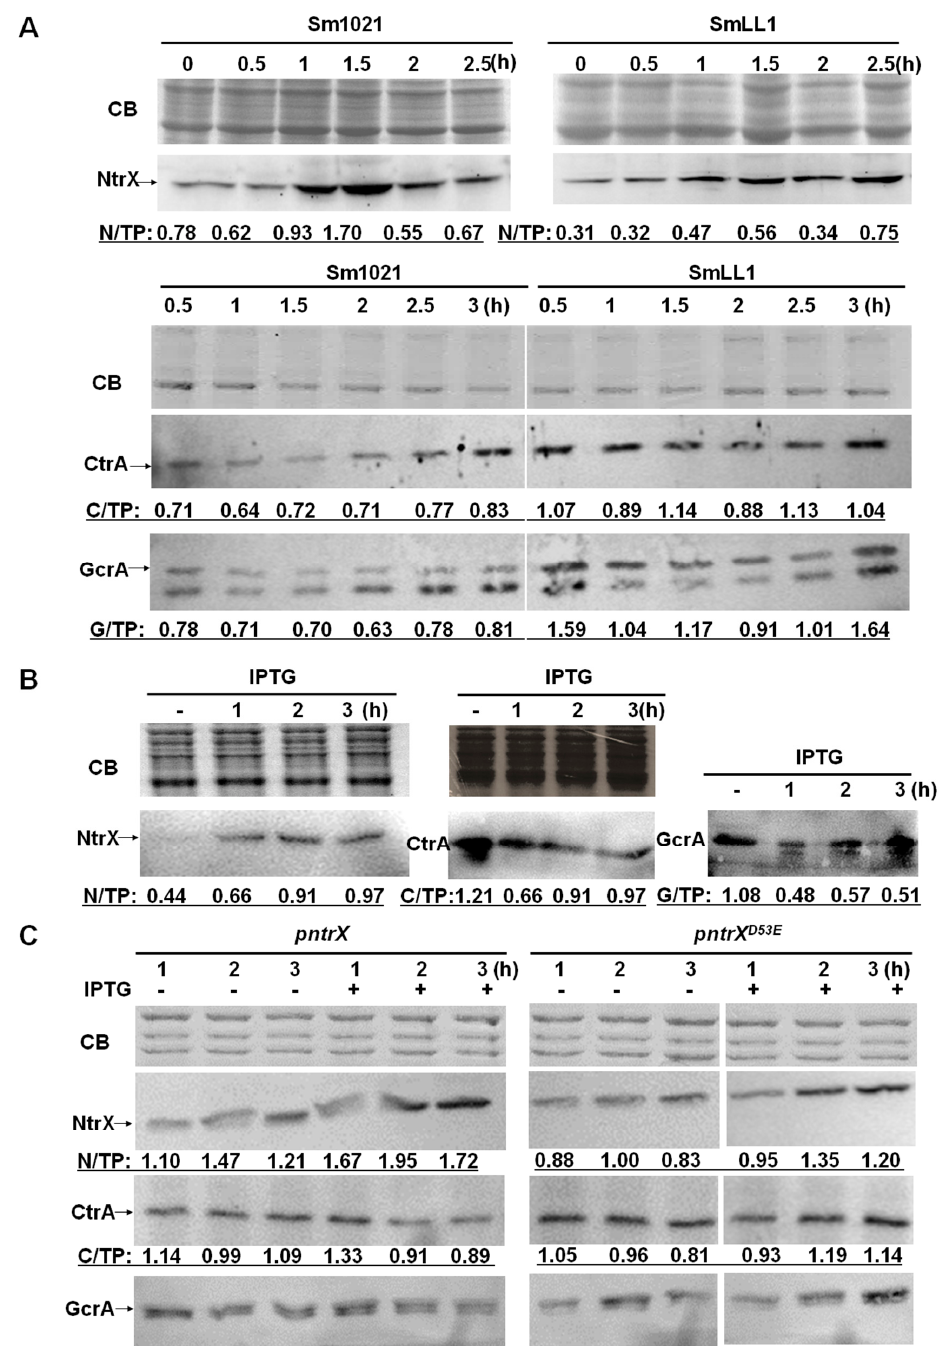
Figure 3. Protein levels of NtrX, CtrA, and GcrA in the ntrX mutant as evaluated by Western blotting. Synchronized cells of Sm1021 and SmLL1 were grown in LB/MC broth for half to three hours in ( A ). The depletion cells were grown in LB/MC broth containing 1 mM IPTG for one to three hours, while the cells were incubated without IPTG for one hour as a control in ( B ). Synchronized cells of Sm1021/p ntrX and Sm1021/p ntrX D53E were grown in LB/MC broth containing 1 mM IPTG for one to three hours in ( C ). CB, total proteins stained by Coomassie brilliant blue. N/TP, C/TP, or G/TP, the blot intensity of NtrX, CtrA or GcrA (the larger one) divided the intensity of the strongest band of the total proteins stained by Coomassie brilliant blue. The intensity data were collected using Image J